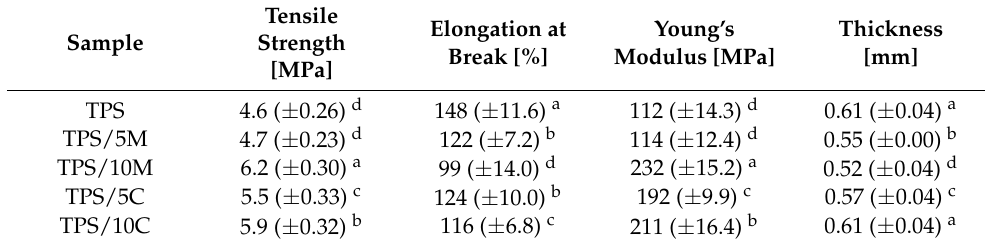
Table 1. Mechanical test